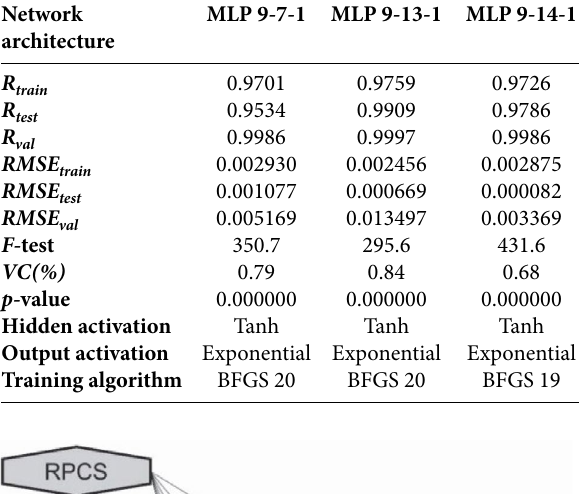
Table 2. The results of ST-ANN procedure. Network